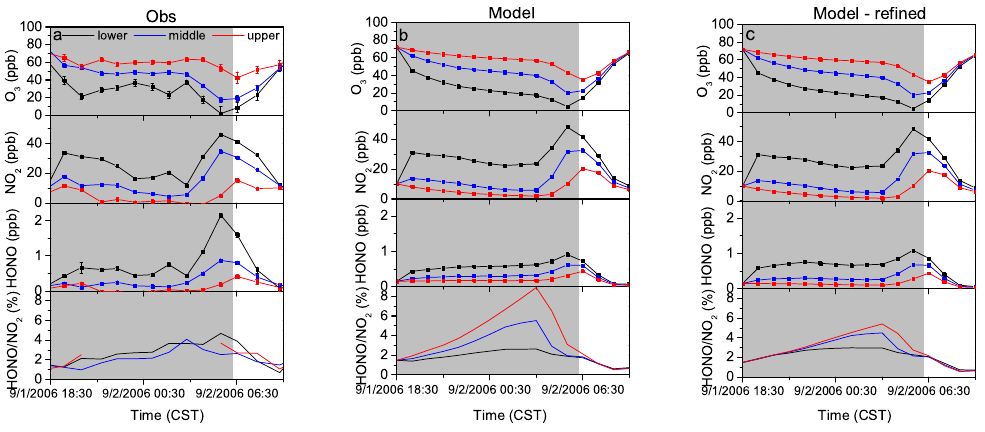
Fig. 4. Comparison of HONO, NO 2 , O 3 mixing ratios and HONO to NO 2 ratios between observations (left) and model results (middle and right) on 1–2 September 2006. (Mixing ratios at lower, middle and upper altitudes are plotted in black, blue and red respectively.) See the Supplement for expanded version of figure.